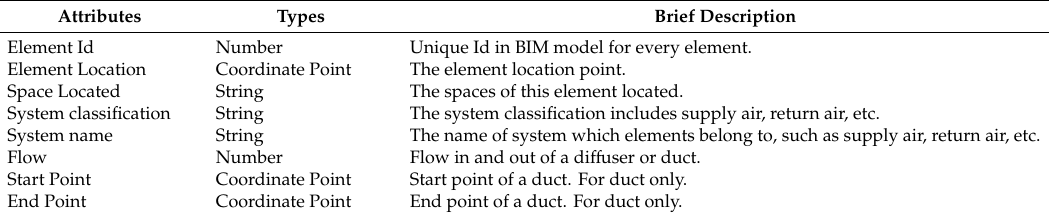
Figure 9. Data structure of MEP subsystem’s components. ( a ) Connection table for illustrating topological relationships. ( b ) Graph structure of the MEP subsystem. ( c ) Inverse adjacent list of MEP components. Table 4. Example of the attributes list.